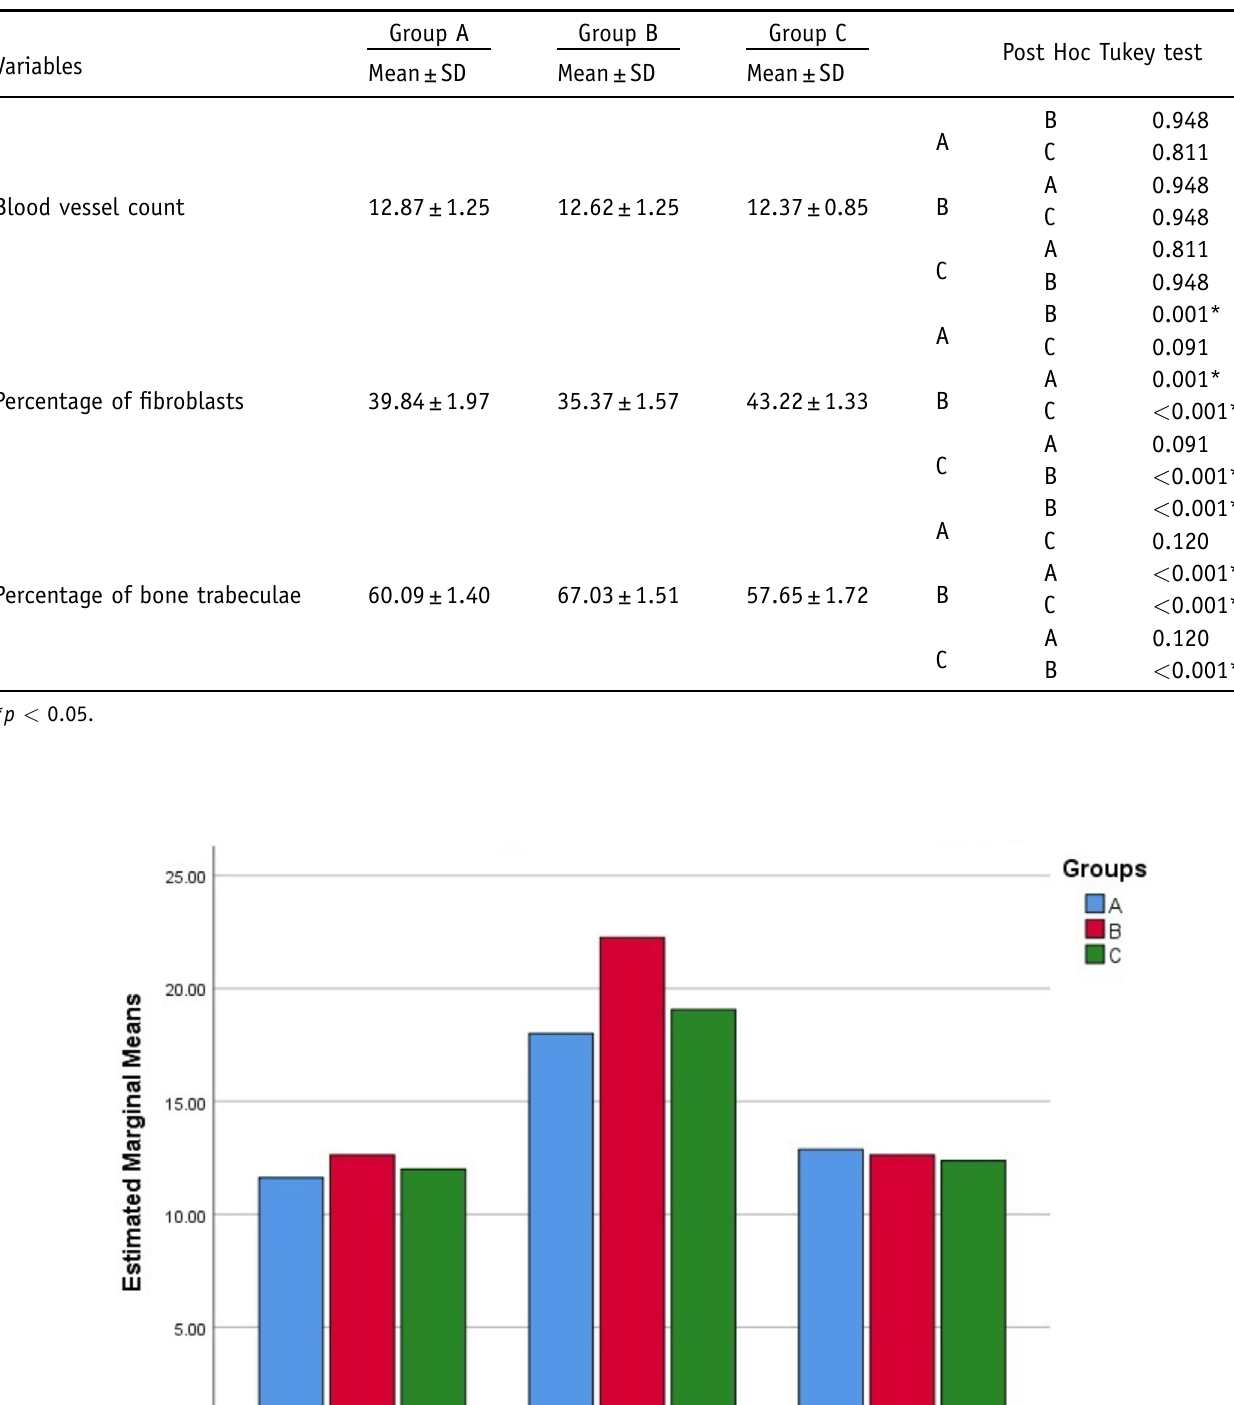
Table III. Descriptive analysis showing mean, standard deviation (SD) and Post Hoc Tukey test of histological variables of Group A, B and C at day 21.